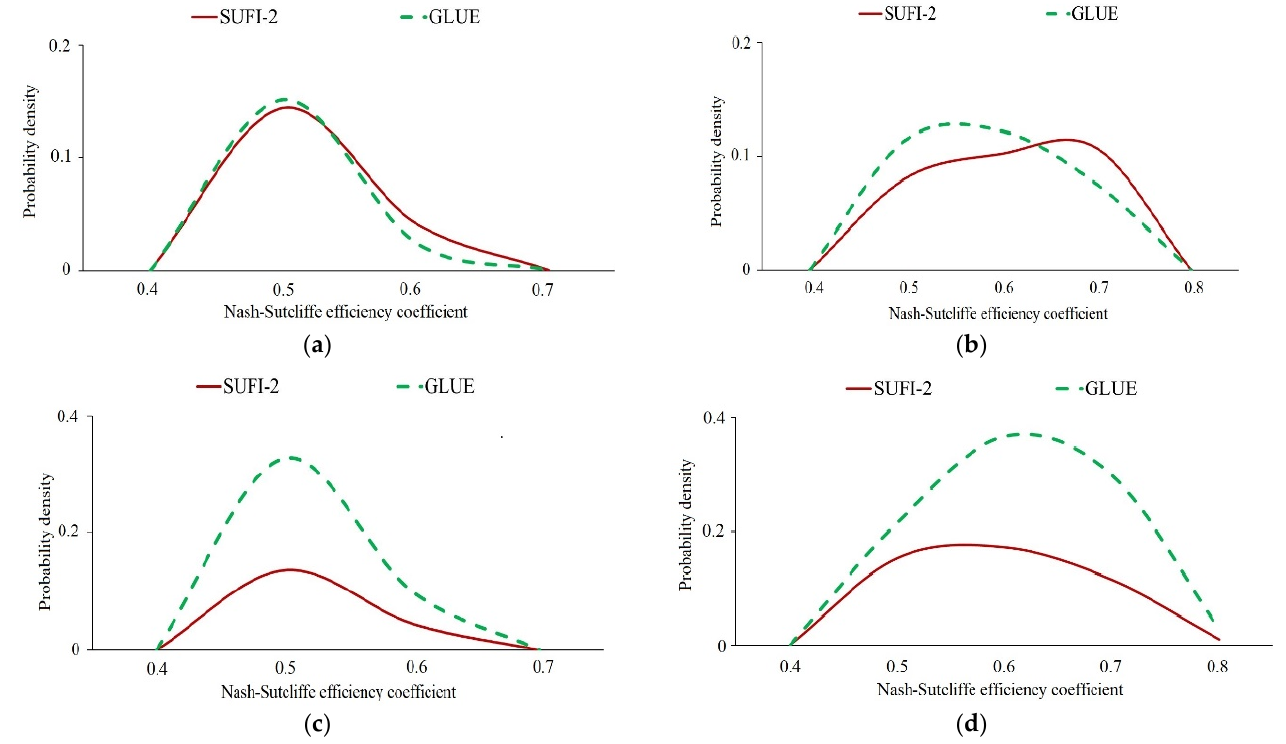
Figure 4. Probability density distributions of behavioral parameters for ( a ) total nitrogen load during calibration and ( b ) total nitrogen load loading during validation and ( c ) total phosphorus load during calibration and ( d ) total phosphorus load during validation.